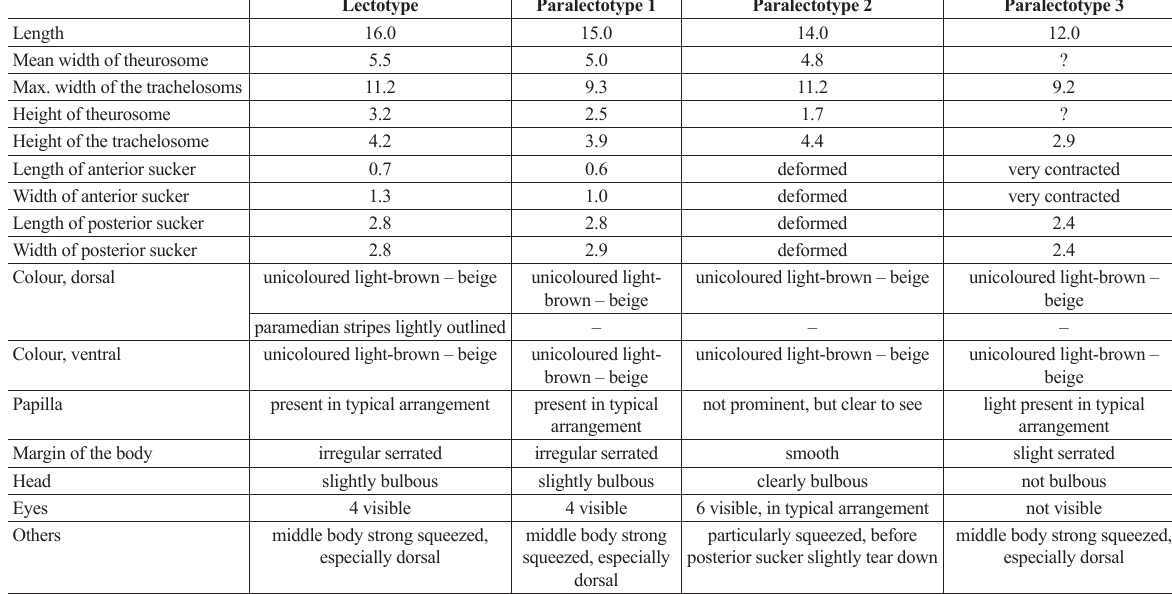
Table 1. Characteristics of the type specimens of Glossiphonia verrucata